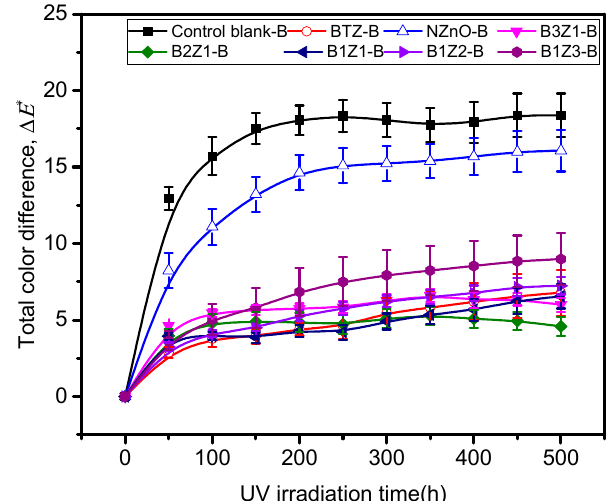
Figure 2. ∆ E * values of bamboo specimens covered with films with di ff erent coating formulations as a function of UV-accelerated aging